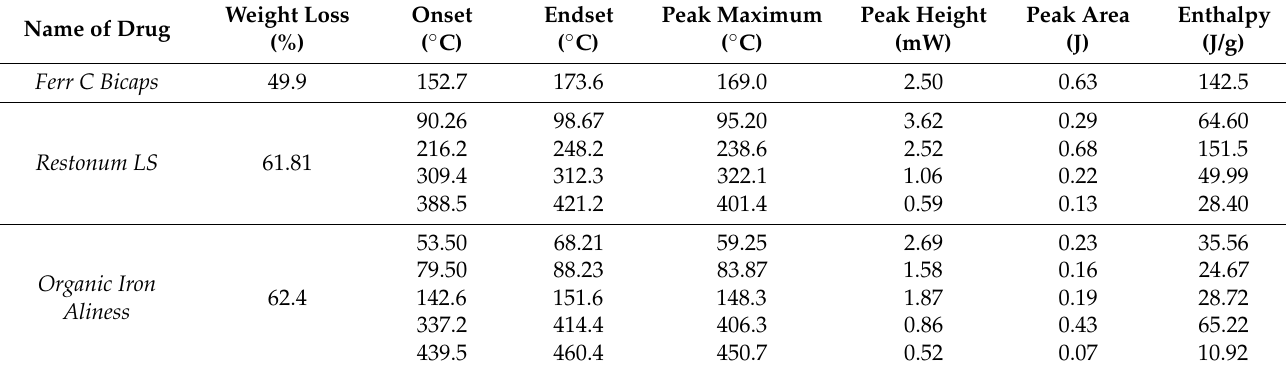
Table 7. Parameters determined from TG and DSC analysis for drugs containing iron (II)